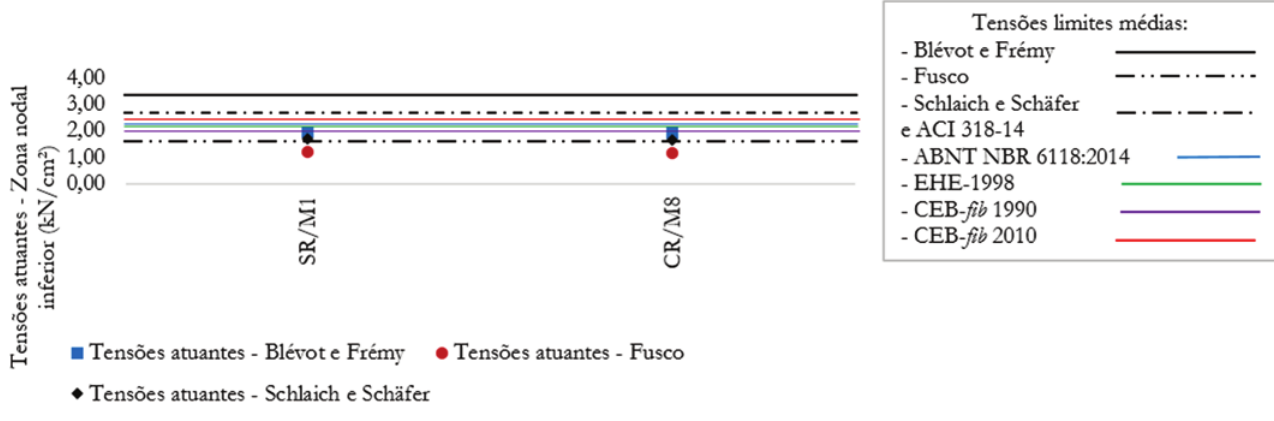
Modelos ensaiados por Barros [10] × σ